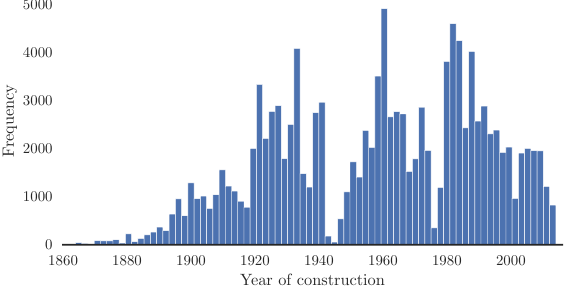
Figure 3. Distribution of buildings in Rotterdam by year of con- struction. The share of buildings constructed before 1860 is neg-